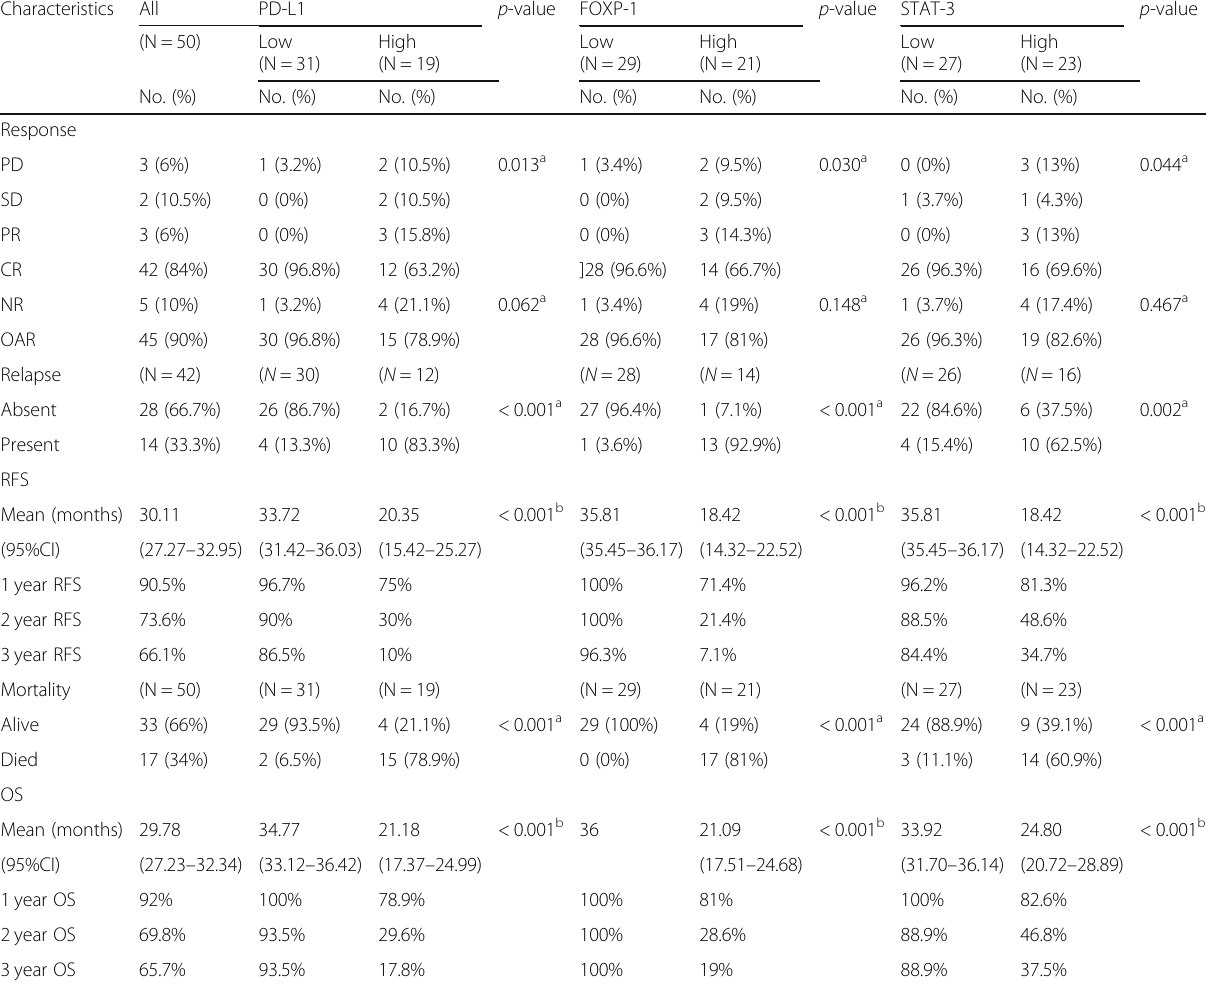
Table 3 Correlation between PD-L1, FOXP-1 and STAT-3 expression and outcome of our patients